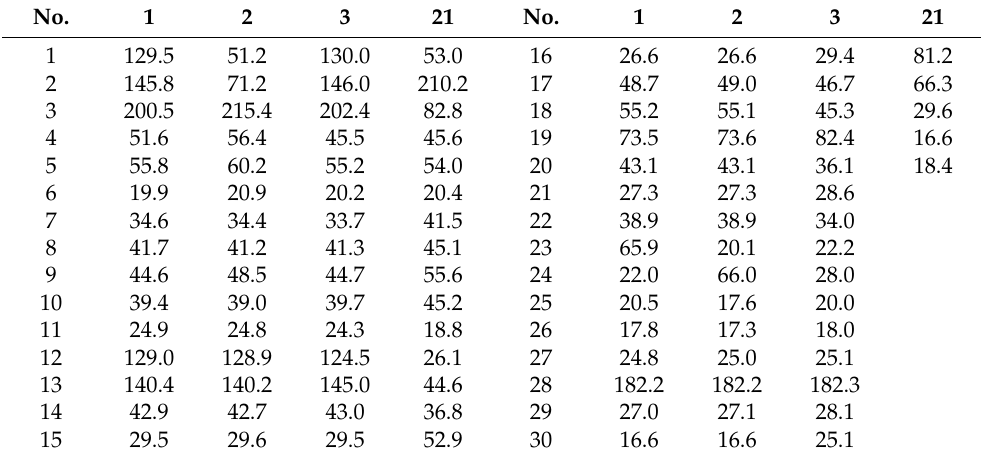
Table 1. 13 C NMR data a ( δ in ppm, 150 MHz) of compounds 1 – 3 (in CD 3 OD) and 21 (in C 6 D 6 ).